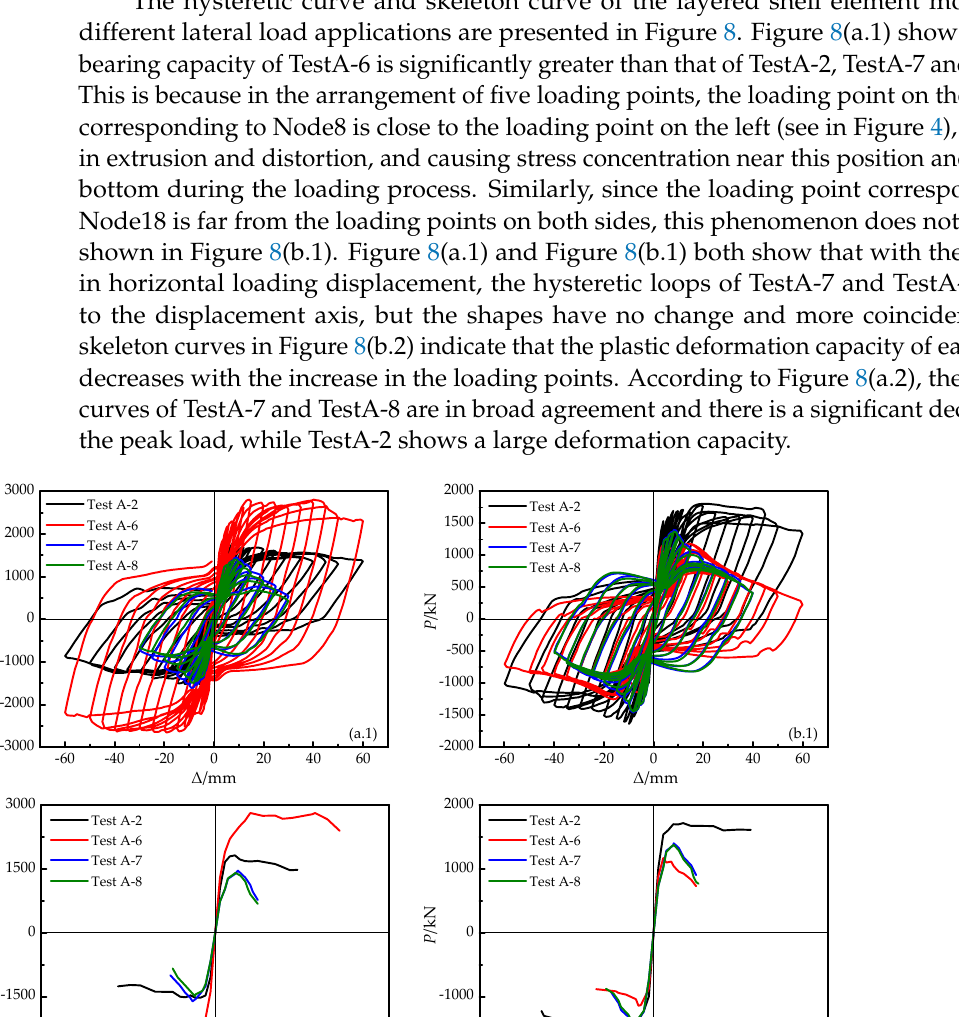
( c ) Figure 9. Accumulative energy dissipation curves: ( a ) Pier top; ( b ) Node8; ( c ) Node18. The cumulative energy dissipation of TestA-8 is 12.74% of that of TestA-2. It can be seen from Figure 9b that for the cumulative energy dissipation at Node8, TestA-6 pos-